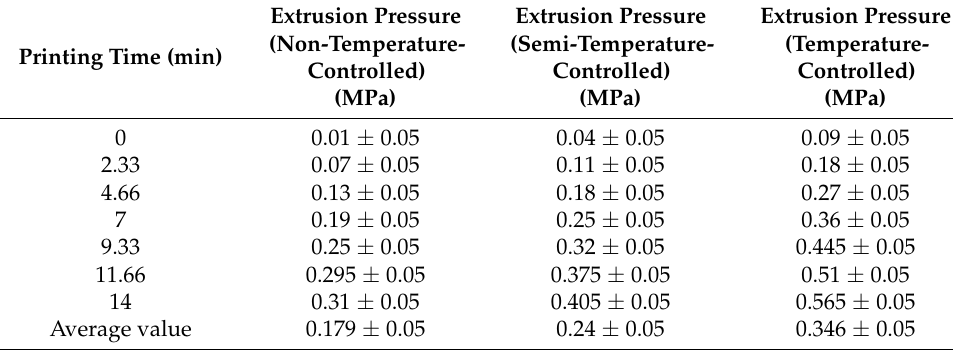
Table 3. Extrusion pressure changes under different printing times.